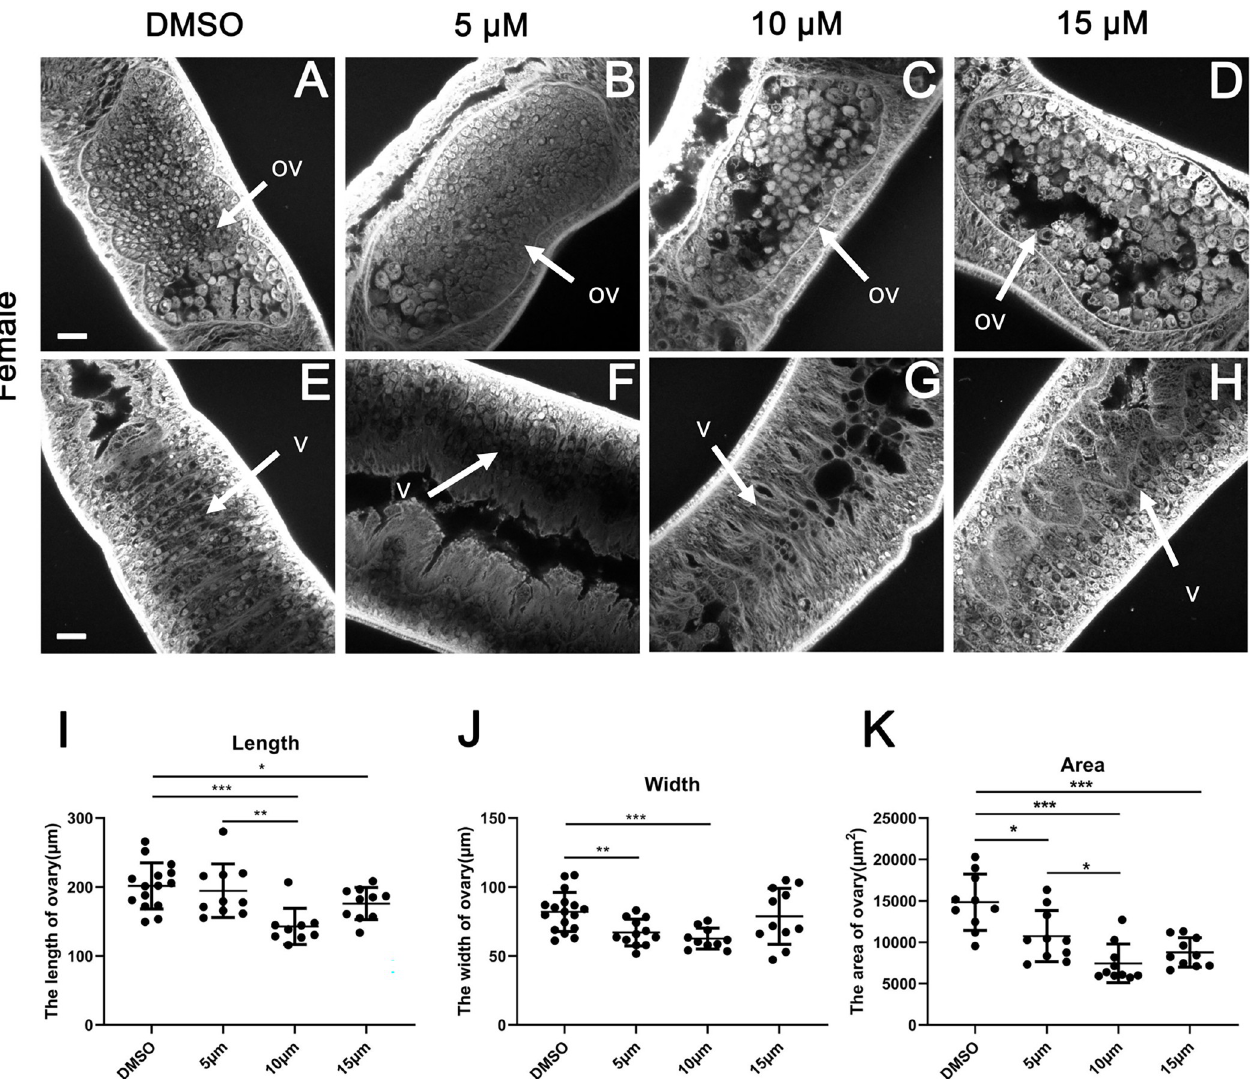
Fig 4. Morphological changes of ovaries and yolk glands in female S . japonicum treated with JQ-1. Worms were stained with carmine hydrochloride and analyzed using confocal laser scanning microscopy. (A, E) Control worms; worms treated with JQ-1 at 5 μ M (B, F), 10 μ M (C, G), and 15 μ M (D, H). Abbreviations: ov, ovary; v, vitellarium; (A-H) Scale bars: 20 μ m. Comparison of the length, width, and area of the ovary after JQ-1 application at the indicated concentration (I-K) for 10 d. Data represent the mean ± SEM (n � 15 for each group). Asterisks show statistical differences ( �� P < 0.05, �� P < 0.01, ��� P < 0.001) tested by one-way ANOVA with multiple